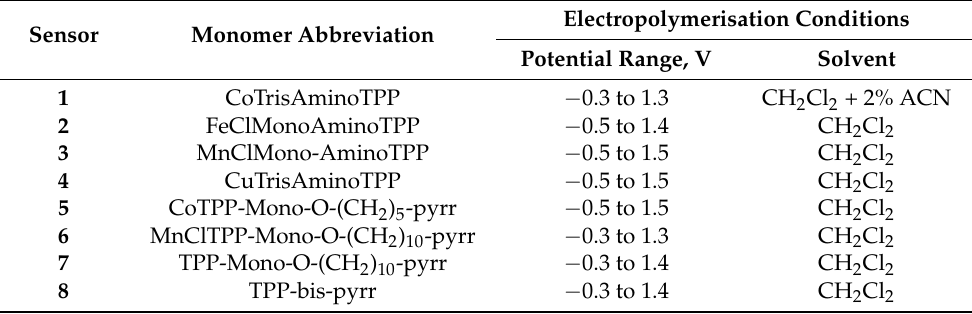
Table 1. Porphyrin polymeric coatings compositions and deposition details.